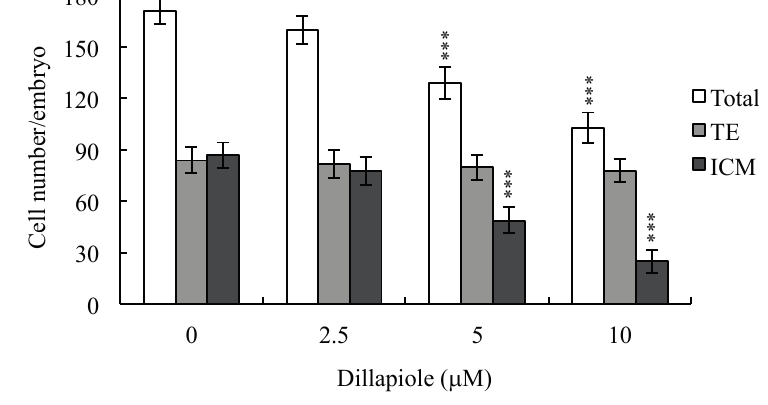
Figure 2. Effects of dillapiole on blastocyst viability. Mouse blastocysts were treated with dillapiole (2.5, 5, or 10 μ M) or left untreated for 24 h, and differentially stained after treatment. Inner cell mass (ICM) cells are stained blue, and trophectoderm cells (TE) stained red. The total number of cells per blastocyst and cell numbers in the ICM and TE were counted. Data are based on at least 180 blastocyst samples from each group. *** p < 0.001 versus the control